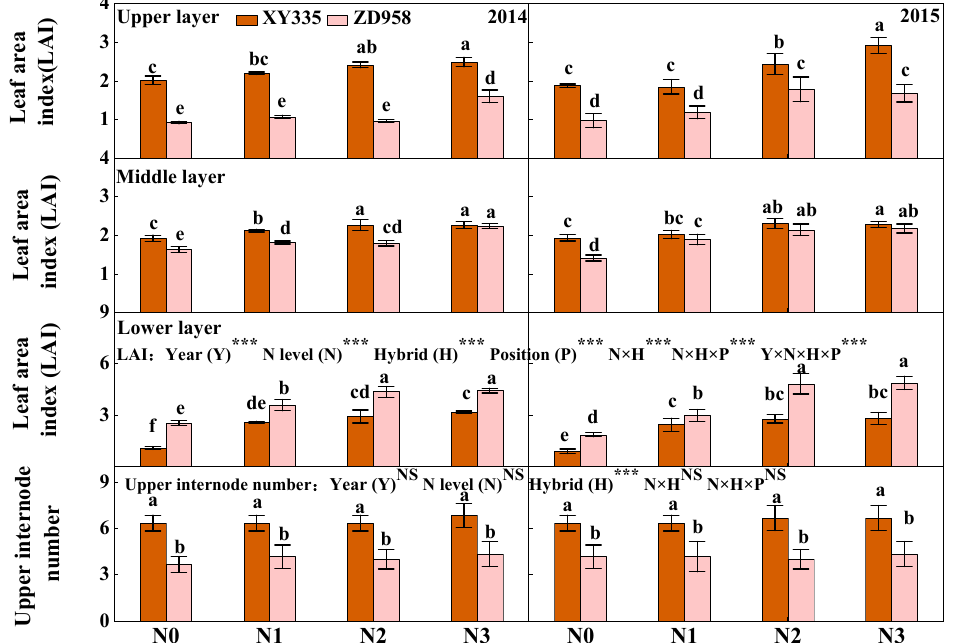
Figure 2. Leaf area index and upper internode number of different maize genotypes at a high plant density in 2014 and 2015. N0, N1, N2, and N3 indicate applications of 0, 100, 200, and 300 kg N ha − 1 , respectively. Different letters indicate a significant difference at the 5% level. Values are shown as the mean ± SE ( n = 3). *** p < 0.001. NS, no